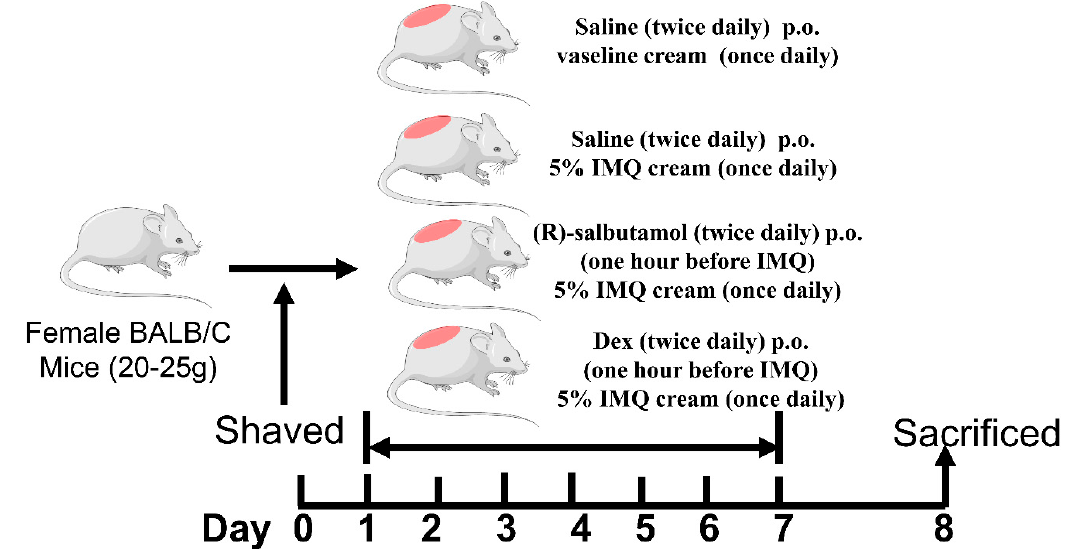
Figure 1. Experimental procedure of the antipsoriatic activity evaluation of ( R )-salbutamol or Dex. one hour after the administration of different doses of ( R )-salbutamol or Dex twice per day, mice in all groups except for the control group received a daily topical dose of 62.50 mg of the imiquimod (IMQ) cream on the shaved area of their backs for seven consecutive days. On day 8, the mice were killed to harvest specimens for experiments.